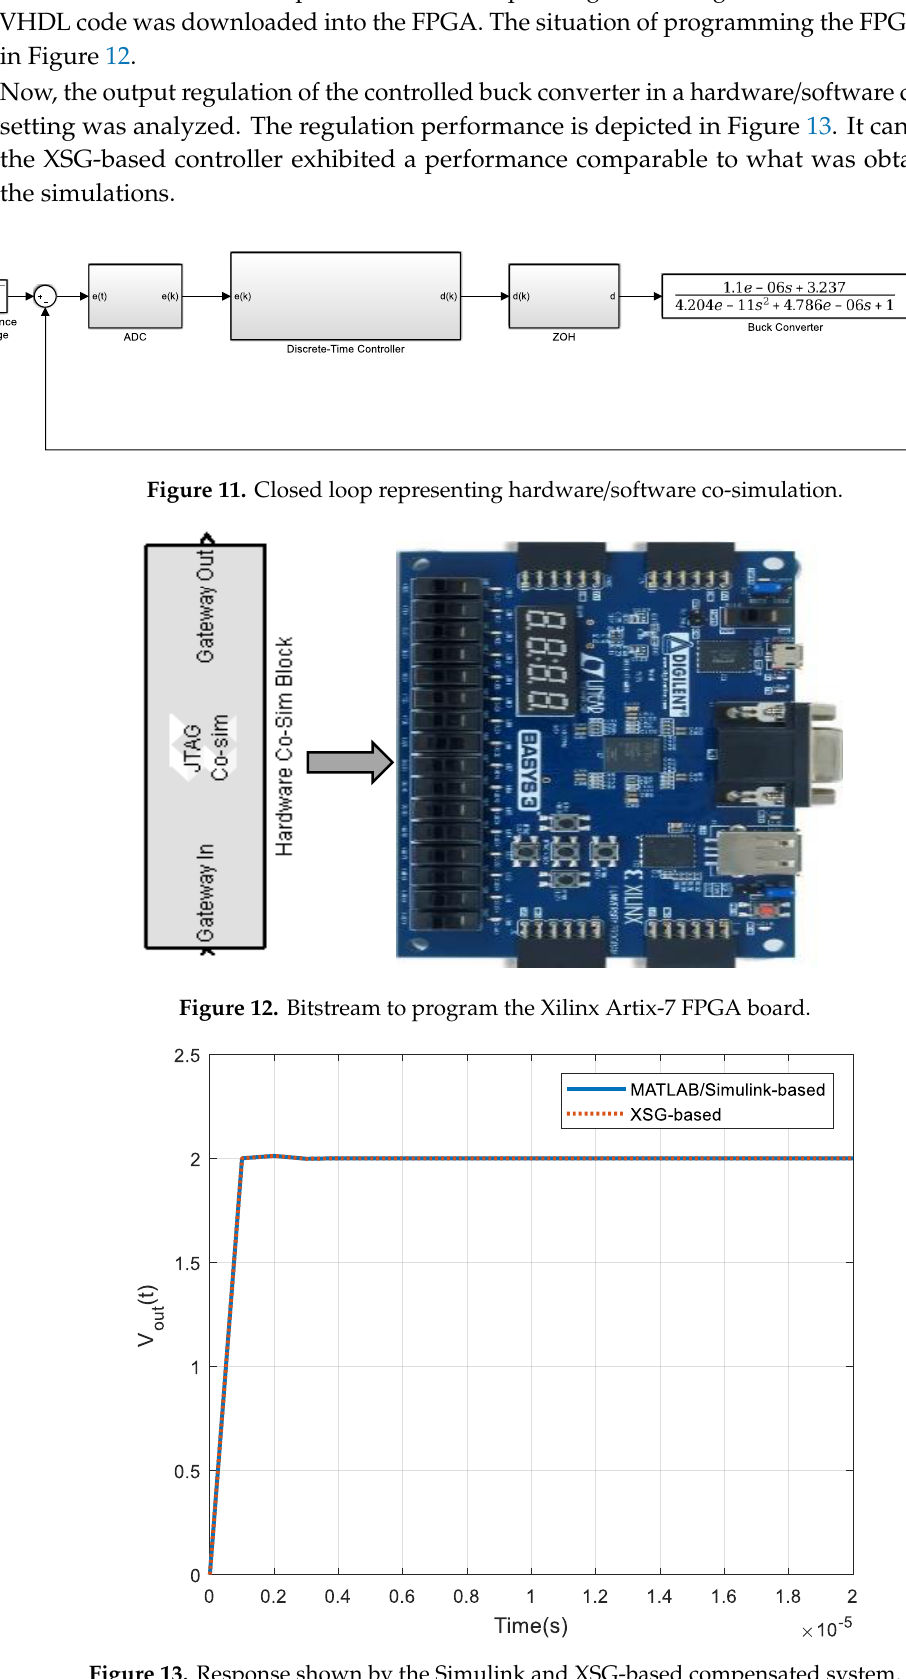
Figure 13. Response shown by the Simulink and XSG-based compensated system.